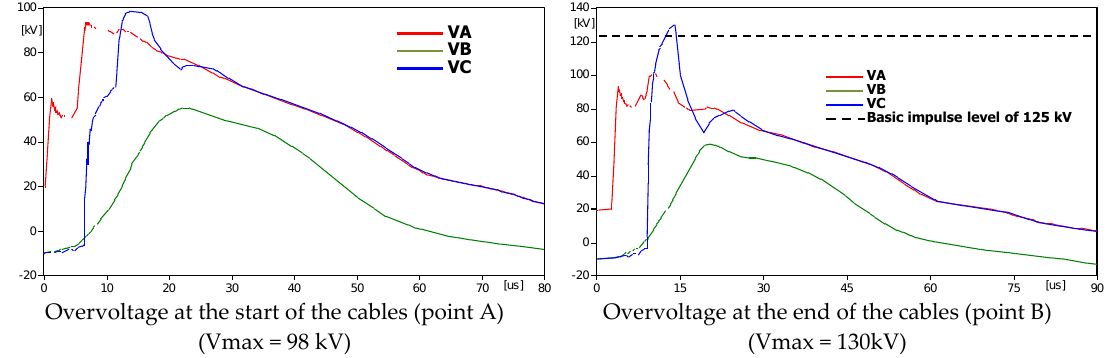
Figure 39. A 500 m underground cable.